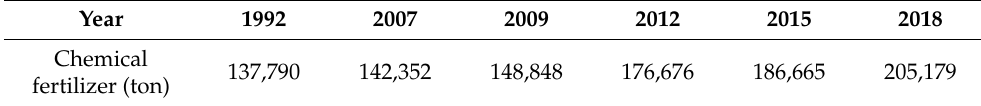
Table 1. Chemical fertilizer inputs in Lishu County in different years.